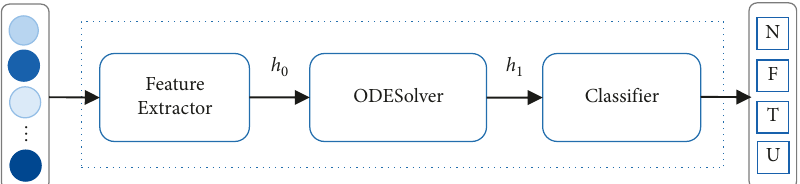
, and h is the dynamic state calculated by NODE 0 1